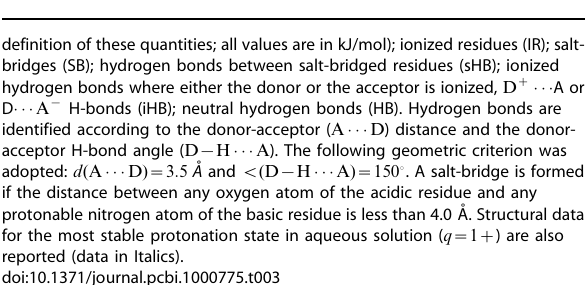
Table 3. Energetics and structural parameters for the lowest- energy conformers of Trp-cage